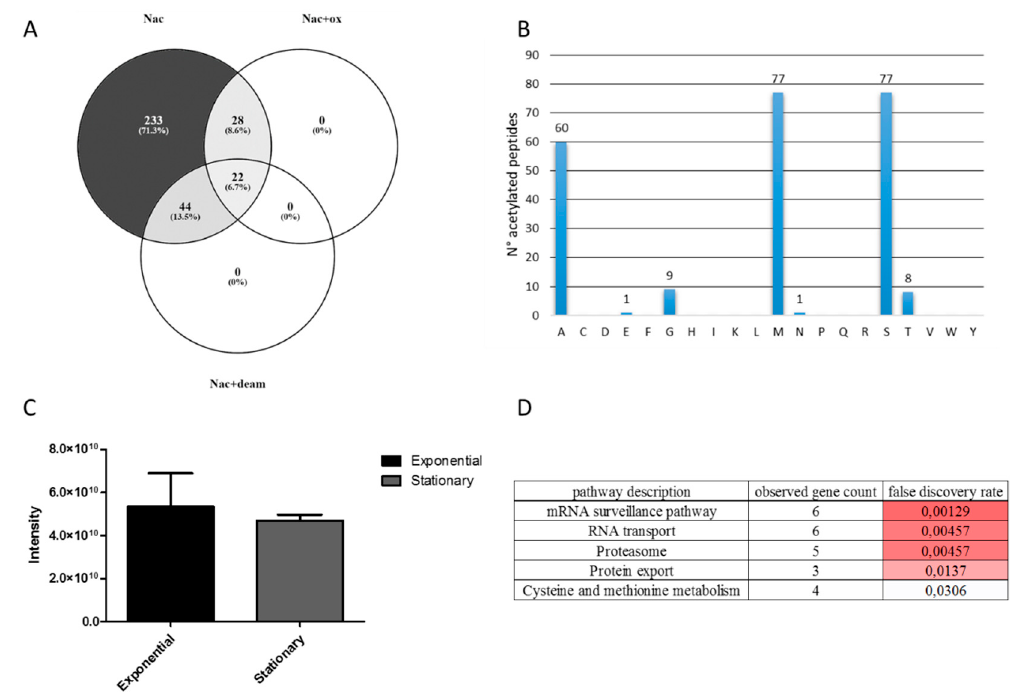
Figure 8. N-terminal acetylated peptides located at the protein N-terminal identified and quantified in the T. cruzi exponential to stationary phase transitioning. ( A ) Venn diagram of N-terminal acetylated peptides containing oxidation of methionine and deamidation of asparagine and glutamine. ( B ) Identity of the total N-terminally acetylated amino acids. ( C ) Intensity of only N-terminally acetylated peptides in the exponential and stationary phases. ( D ) Kyoto Encyclopedia of Genes and Genome (KEGG) pathways associated to N-terminally acetylated proteins. The adenylate kinase enzyme (Q4E1S6, Tc00.1047053506855.180) was found downregulated at